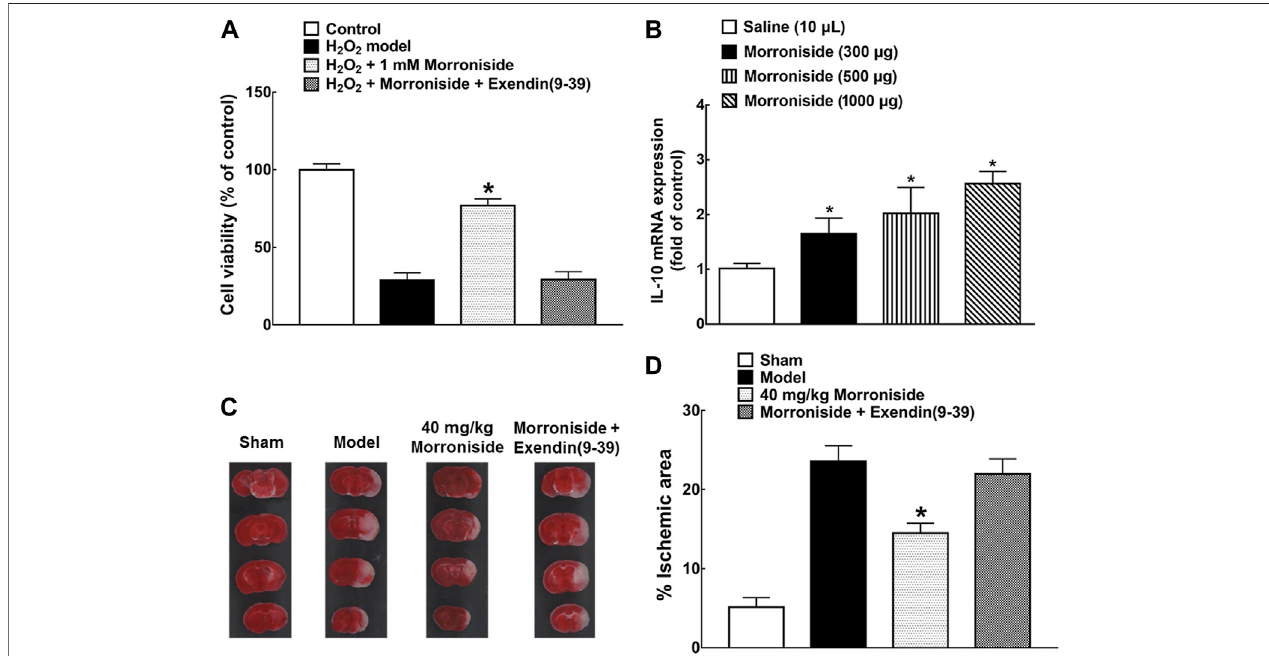
FIGURE4| TheneuroprotectiveeffectofmorronisideinMCAOmice. (A) GLP-1Rmediatedtheeffectofmorronisideagainstcelloxidativedamage; (B) IL-10mRNAlevel in the cortical penumbra area in MCAO mice after multiple treatment of morroniside twice-daily by intracerebroventricular injection on day 3 after surgery; (C, D) the neuroprotective effect of morroniside was evaluated by intravenous injection in MCAO mice, while the GLP-1R antagonist exendin (9-39) completely inhibited its activity. The quantitative analysis was done by TTC staining ( n (cid:2) 6 – 8). The data were presented as mean ± SEM. Compared with model control group, * p < 0.05 denoted statistical signi fi cance by using one-way ANOVA and post hoc Student – Newman – Keuls tests in panel (B) or unpaired and two-tailed Student t -test in panels (A) and (D) .